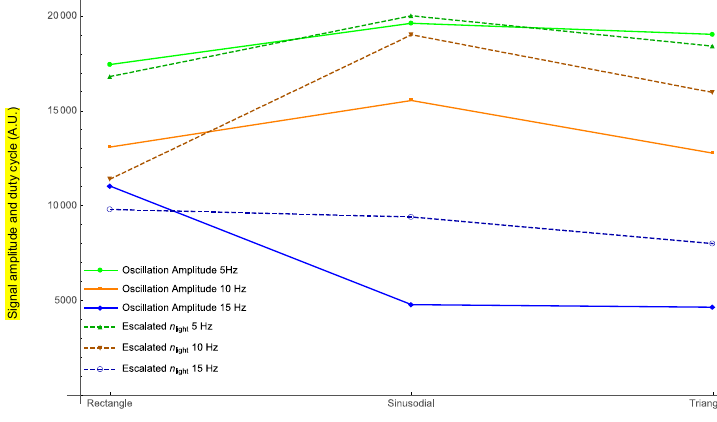
Figure 7. Behavior of the photodyne displacement (in nanometers) against three different types of waveforms. The parameter n light has been normalized for the representation.